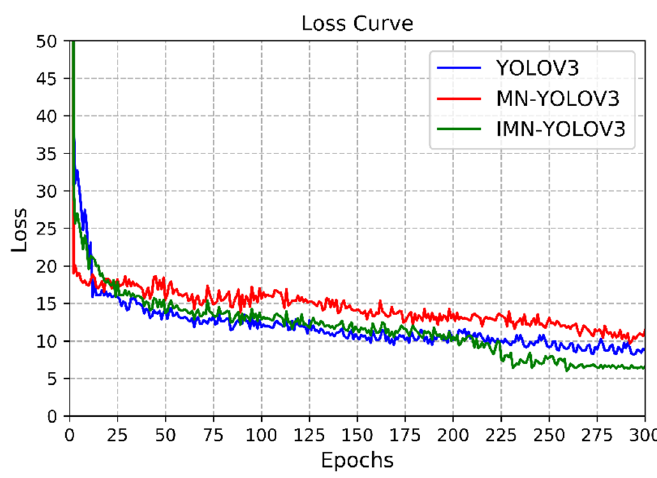
Figure 8. Loss curve of the three YOLO models.